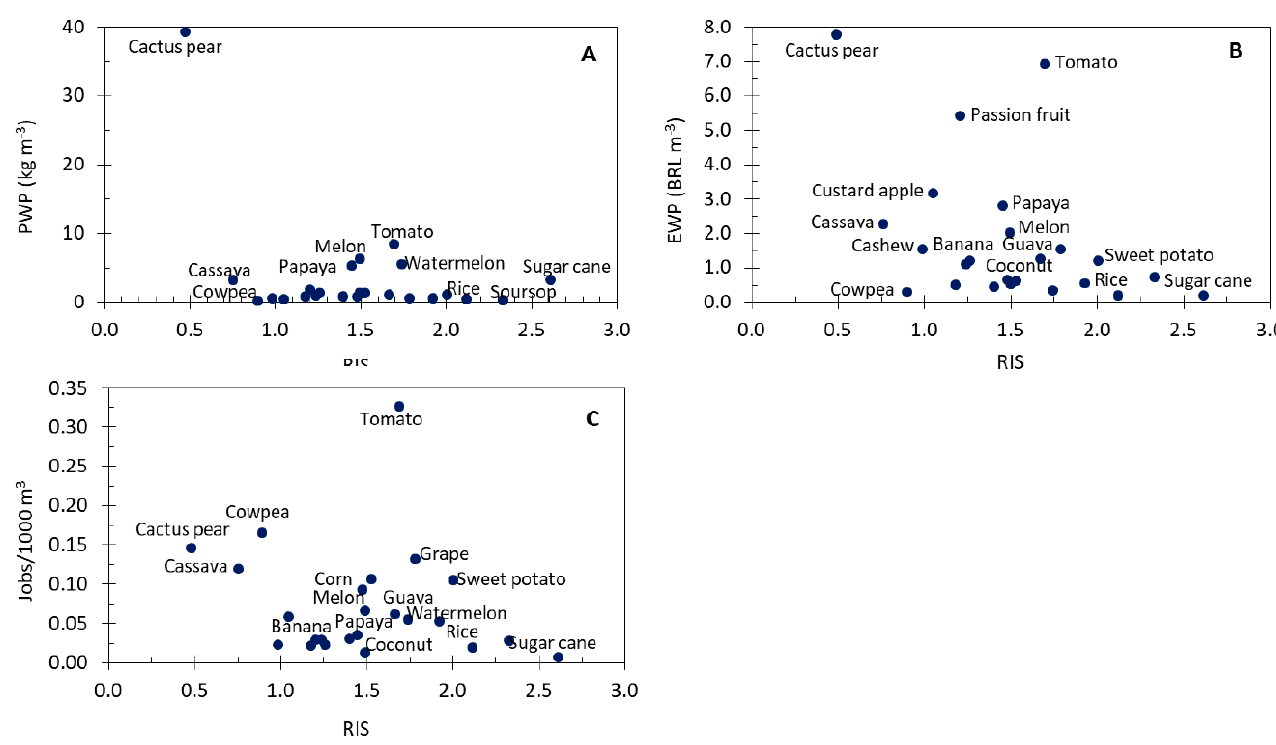
Figure 2. Physical water productivity ( A ), economic water productivity ( B ), and generation of jobs per 1000 m 3 of applied water ( C ), as a function of the relative irrigation supply for some crops selected in the Lower Jaguaribe sub-basin.